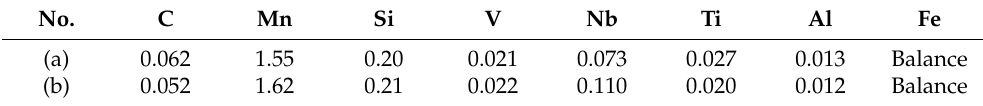
Table 1. Chemical analysis of tested steels